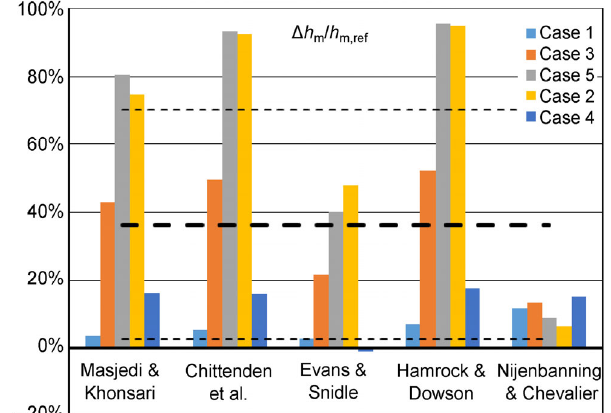
Fig. 3 Relative deviations given by analytical EHD film thickness expressions on h m , the minimum film thickness, for the 5 circular reference cases defined in Table